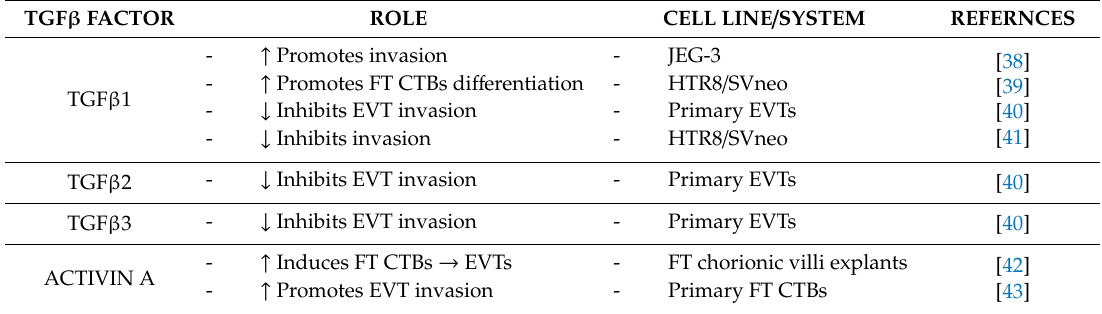
Table 1. The role of the TGF β family in human placental development. FT: First trimester, JEG-3: Human choriocarcinoma cell line, HTR8 / SVneo: Immortalized first trimester human CTBs, Rcho-1: Rat choriocarcinoma cell line, JAR: Human choriocarcinoma cell